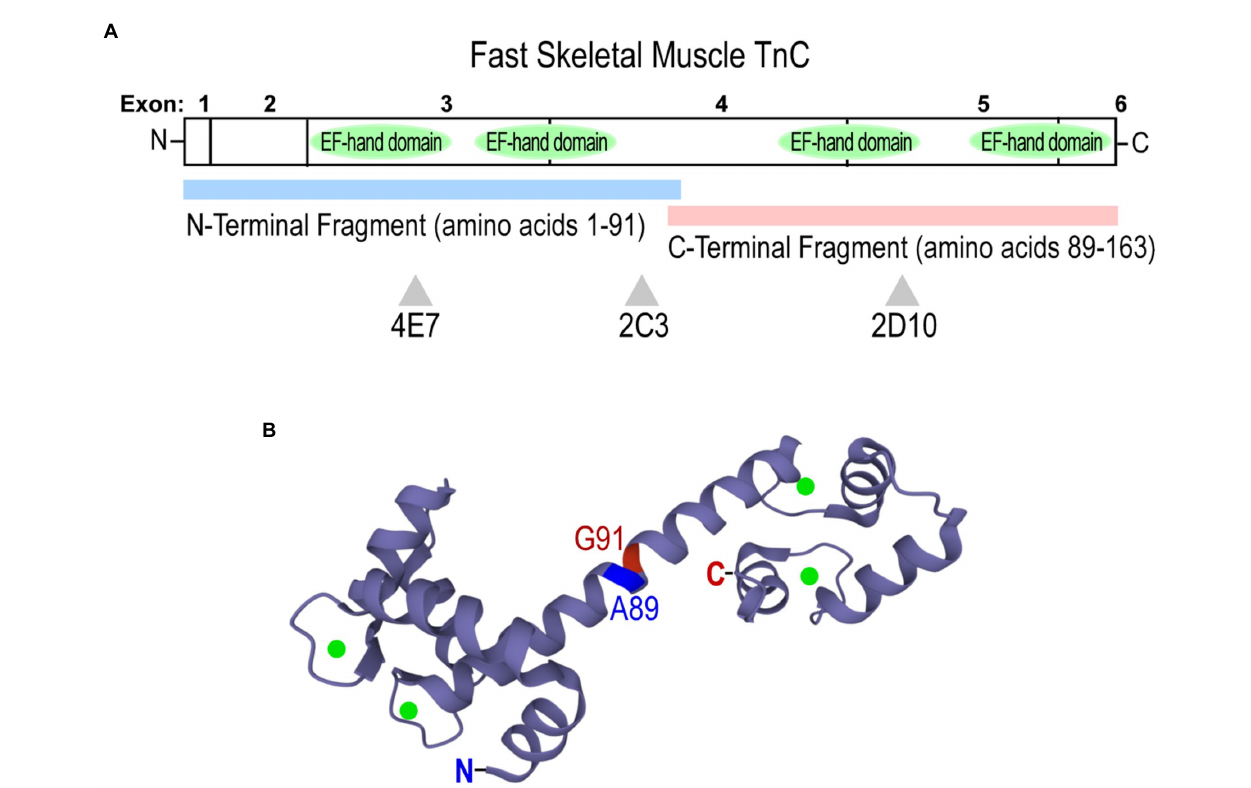
FIGURE 4 | Structure of chicken ( Gallus gallus ) fast skeletal muscle TnC. (A) A linear map showing locations of epitopes recognized by anti-TnC mAbs 4E7, 2C3, and 2D10 used as conformational probes in the present study. Fast TnC consists of N and C terminal domains containing four E-F hand Ca 2+ -binding motifs, along with a central helical linker to connect the domains. N-terminal (amino acids 1–91) and C-terminal (89–163) fragments were employed to map epitopes of the mAbs. (B) A crystal structure of fast TnC in the Ca 2+ -saturated state (PDB: 1YTZ; Ca 2+ ions are present as green spheres). The N and C termini, and the boundary of the N- and C-terminal fragments used for mAb epitope mapping are